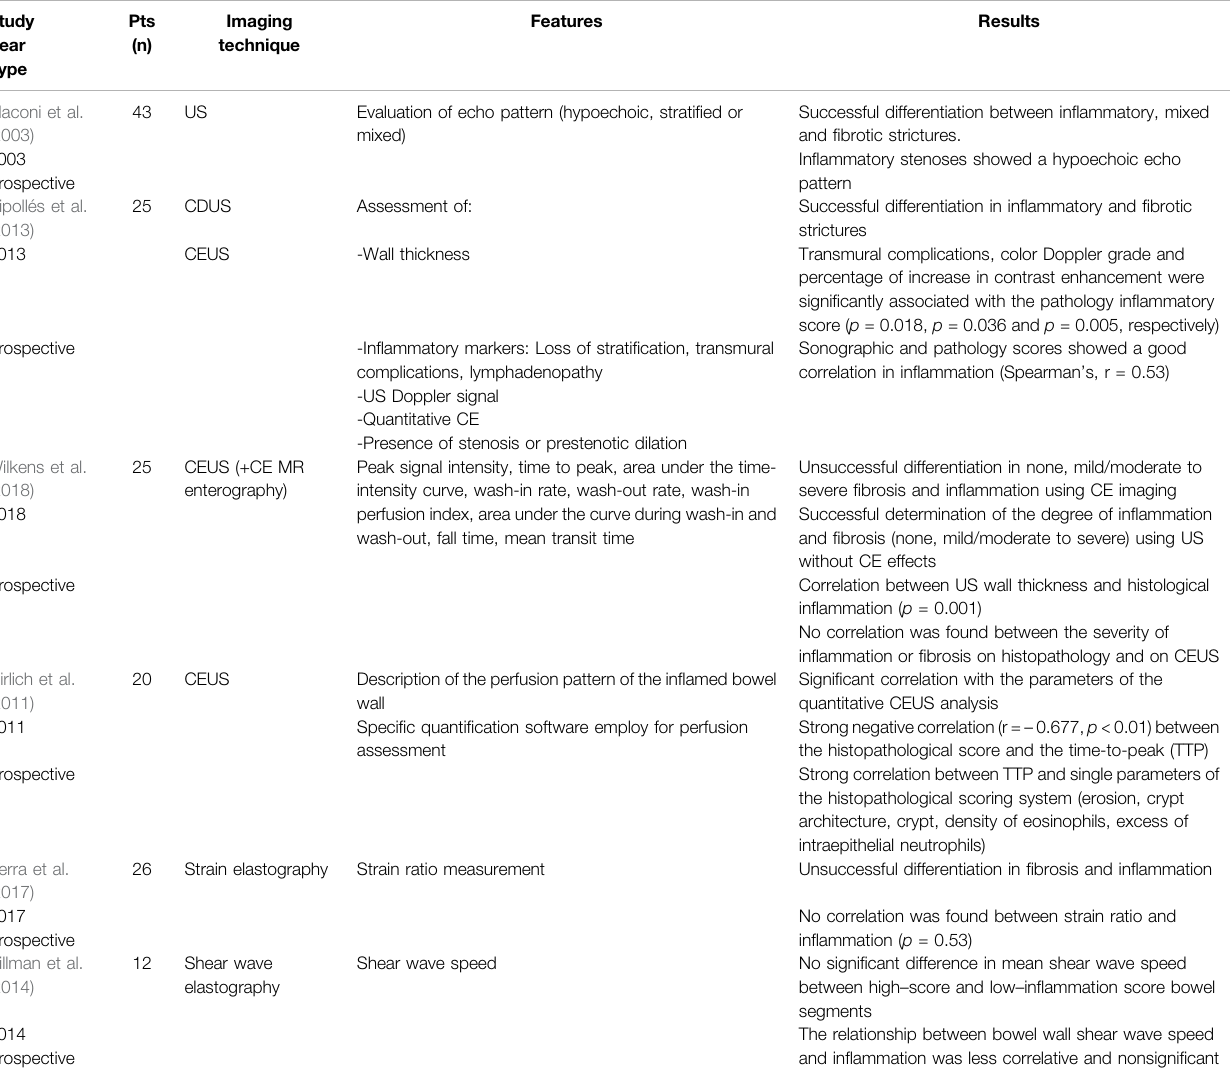
TABLE 1 | Imaging techniques and assessment of in fl ammation in CD compared with histology (i.e., reference standard: histopathology resection). Adapted from Bettenworth et al. (2019) and Gordon et al.